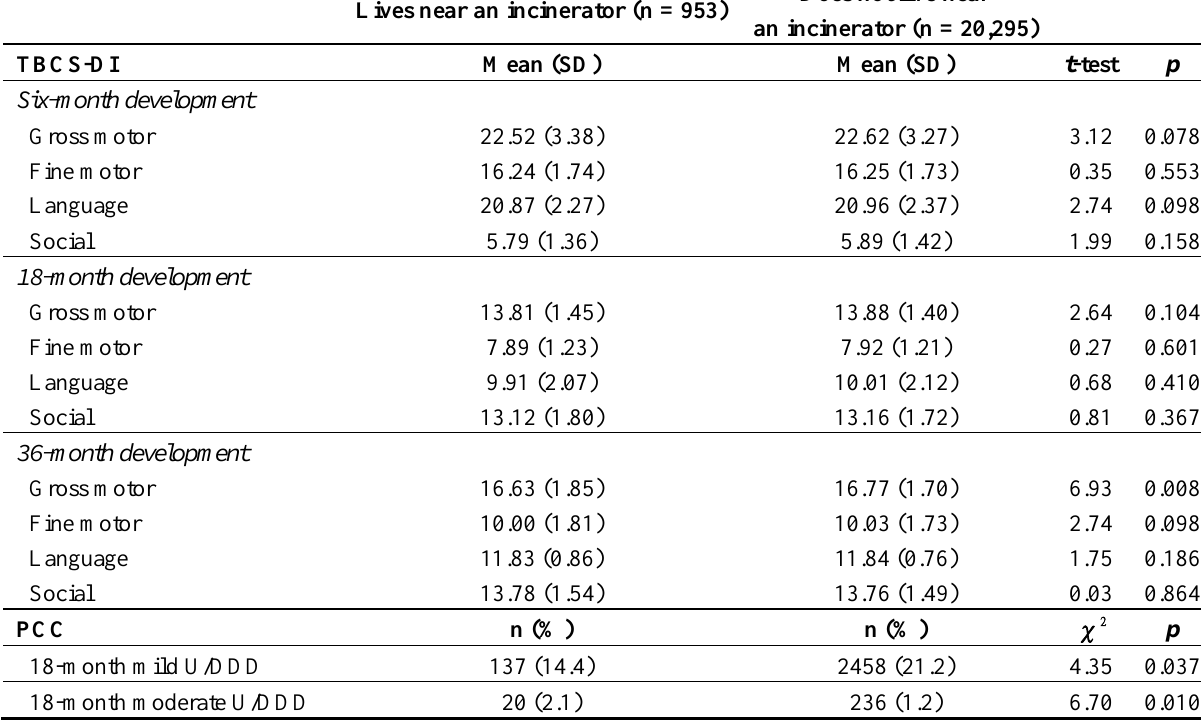
Table 2. Comparison of child development, using the Taiwan Birth Cohort Study- Developmental Instrument (TBCS-DI) and the Parental Concern Checklist (PCC), between those who lived near an incinerator and those who did